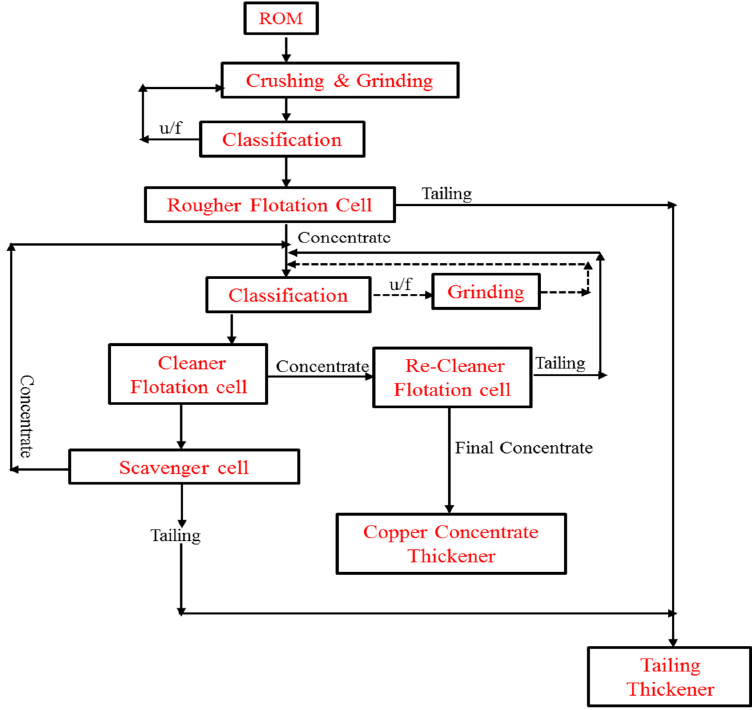
Figure 21. Flow sheet of the Sungun Copper Flotation plant [153].